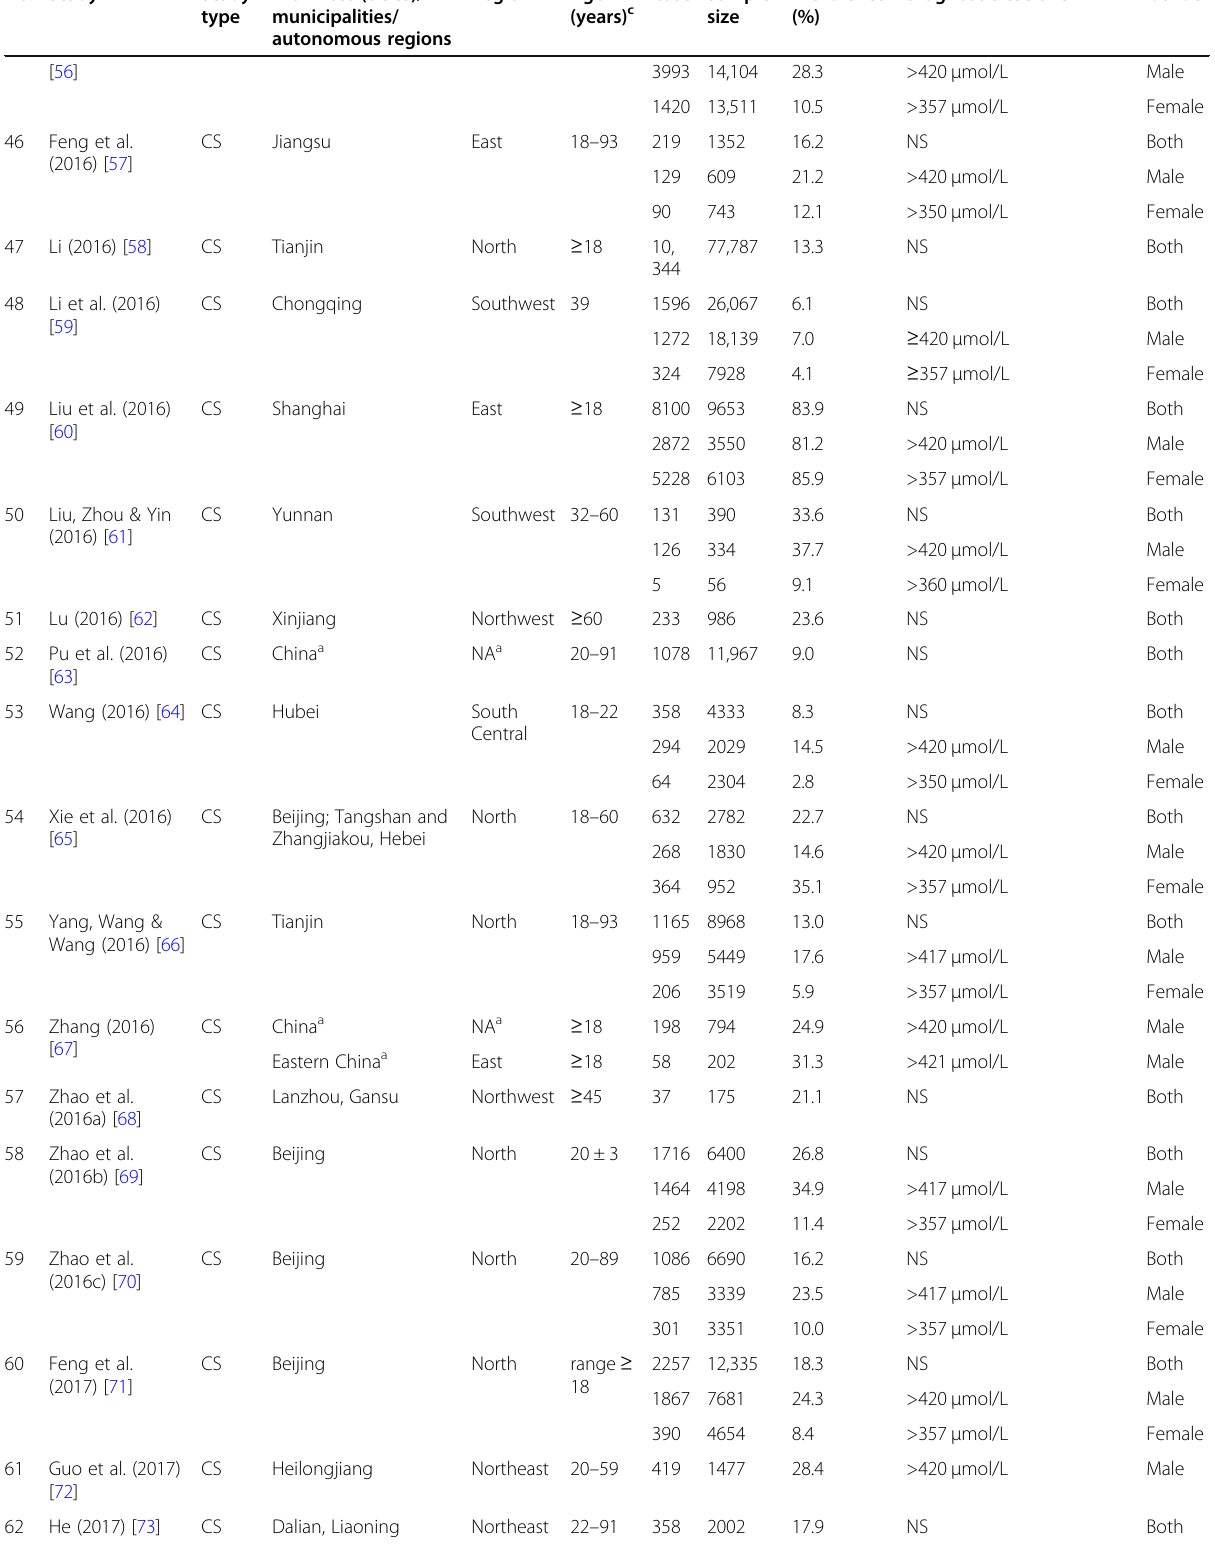
Table 1 Characteristics of the included studies in the systematic review and meta-analysis (Continued) No.